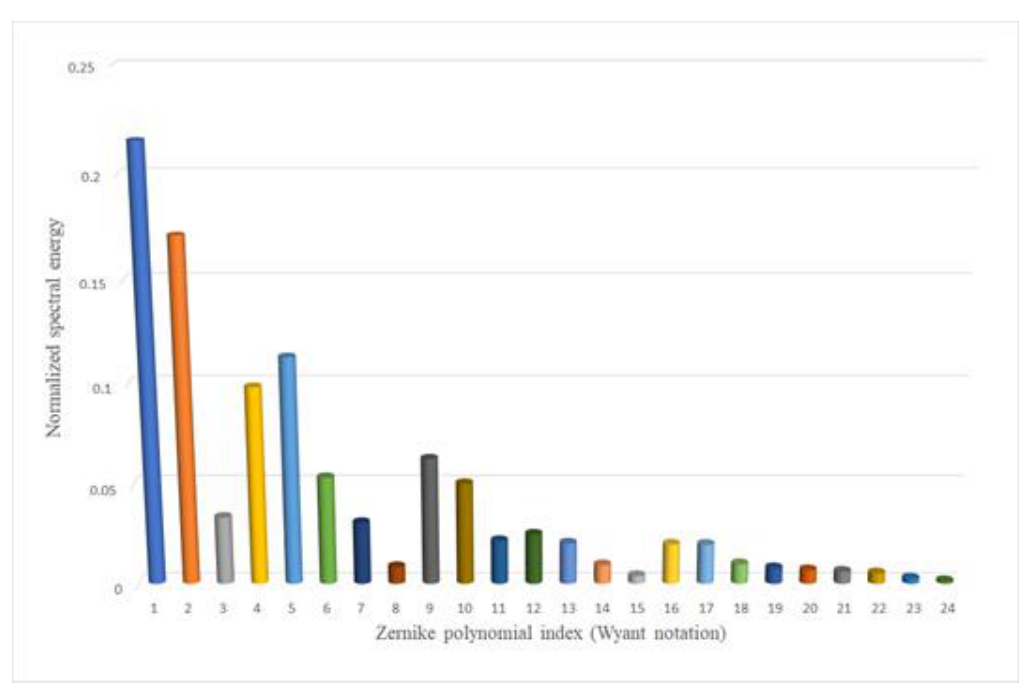
Figure 12. The spectral energy of wavefront aberrations before correction.